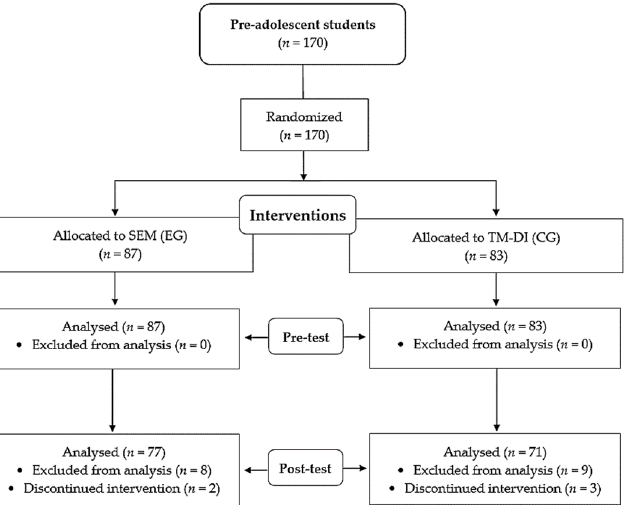
Figure 1. Flow diagram of interventions based on the sports education model (SEM; EG); physical education traditional model of direct instruction (TM-DI; CG).